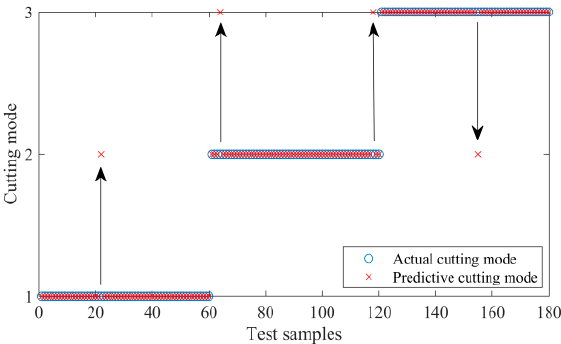
Figure 9. Cutting pattern recognition results.